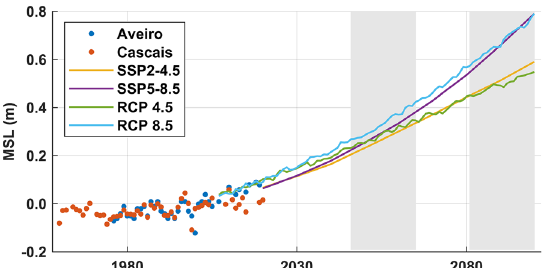
Figure 2. Mean sea level changes on the Portuguese Coast. The points represent observations and the lines projections. Observations and RCP scenarios are annual mean values relative to 1986–2005 and SSP scenarios are decadal mean values relative to 1995–2014. Climate induced mean sea level changes were evaluated by analyzing the sea level projection data from the IPCC climate projections (AR5 and AR6) for the Portuguese Coast.